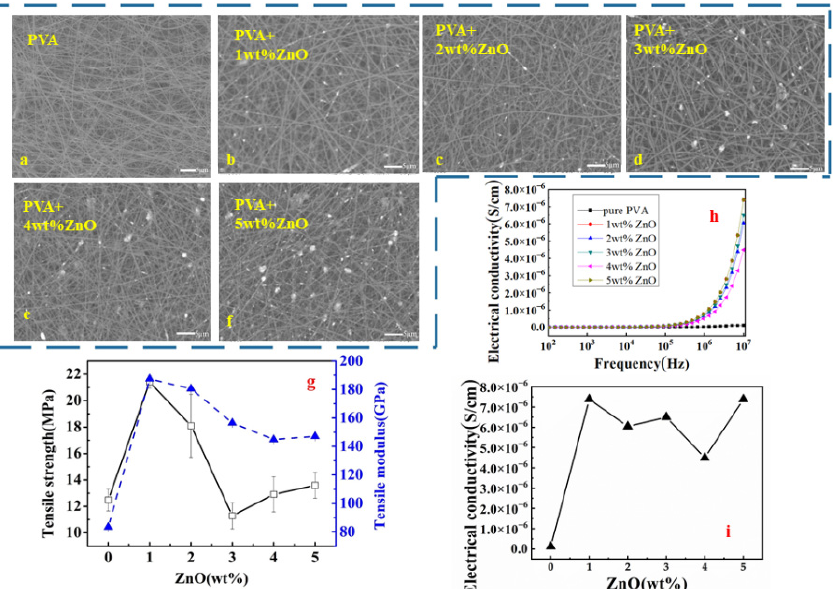
Figure 1. The performance of PVA/ZnO membrane in different mass fractions: ( a – f ) the surface of the membrane by SEM; ( g ) the tensile strength and modulus of membrane; ( h , i ) the conductive property of membrane in different frequencies.